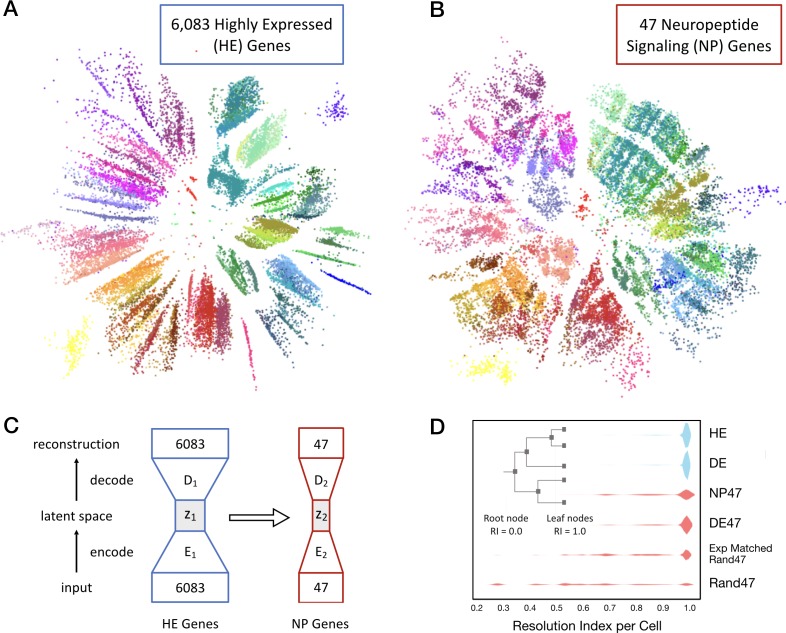
Neurons can be clustered effectively based on just 47 NP genes (18 NPP and 29 NP-GPCR).(A) A two-dimensional latent space representation of 22,439 cells based on 6083 highly expressed (HE) genes obtained by an autoencoding neural network. Dots represent individual cells, colored according to the type-code assignments of Tasic et al. (2018) (see Figure 3—figure supplement 1). Cells of the same type appear as grouped into distinct islands, which suggests that classifiers trained to identify cell types would perform well with such low dimensional representations of gene expression. (B) Two-dimensional representation of neurons in such a latent space z2, based on the 47 NP genes. (C) Schematic of the network architecture used to train the second autoencoder that learns to represent neurons in a latent space z2 that is similar to z1. This second autoencoder represents cells in the latent space based on much smaller gene sets. (D) Inset illustrates resolution index (RI) associated with nodes on the hierarchical tree used in the per-cell RI calculation. RI distribution (see Materials and methods) for NP genes-based cell type classification shows that a vast majority of the cells can be correctly classified up to the type level (leaf nodes, RI = 1.0) of the Tasic 2018 hierarchy. Errors in classification (RI <1.0) at the type level are nevertheless resolved at the class level of the hierarchy, as indicated by the high values for RI for the remaining cells. High average RI for HE genes, and 4020 differentially expressed (DE) genes, and 47 DE genes indicates that the cell type classification procedure based on autoencoder representations is accurate. The average RI for cell type classification based on the 47 NP genes is significantly higher (p<0.01, bootstrap) than both, subsets of 47 genes selected randomly (Rand47, n = 100 subsets), and selected randomly but with expression levels matched to the NP genes (Rand47 ExpMatch, n = 100 subsets).